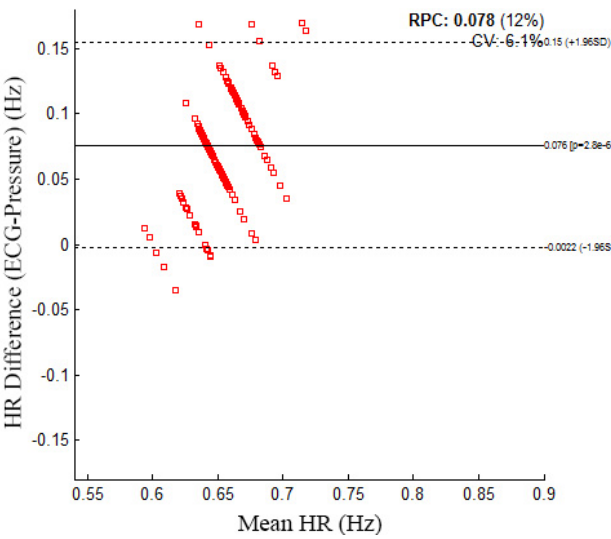
Figure 8. Bland–Altman plot with a mean difference of 0.076 that shows the limit of agreement of 95% (dashed lines are mean differences ± the limit of agreement) between the continuous heart rate (HR) of pressure signal and its corresponding electro-cardiogram (ECG)